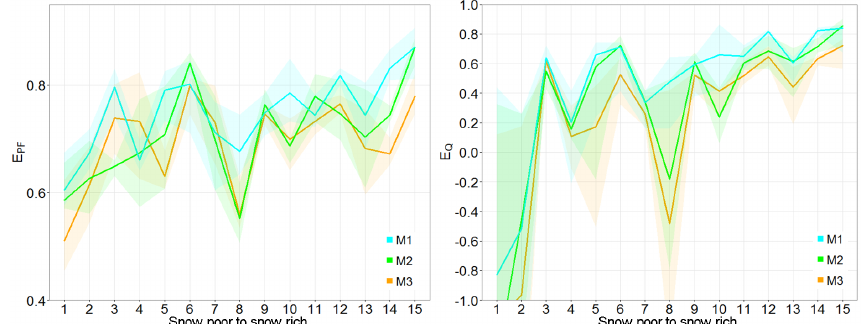
Figure 7. Results of the leave-one-out approach for catchments with mean elevation above 2000ma.s.l. Median (solid lines) and interquartile (25th–75th percentile; shading) range of E PF (left panel) and E Q (right panel) for validation years ordered from snow-poor (index = 1) to snow-rich (index = 15)